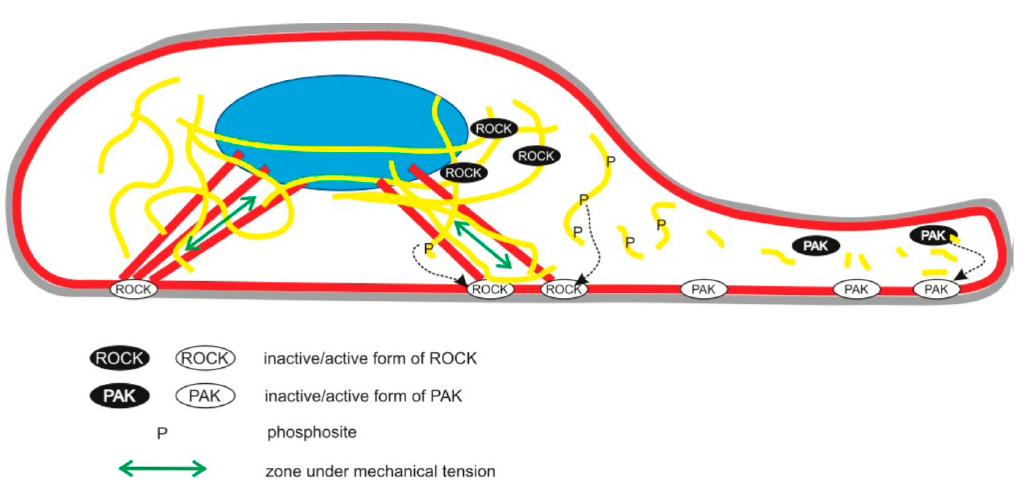
Figure 5. Working hypothesis. Image showing the plasma membrane (grey), nucleus (blue), actin cytoskeleton (red), and vimentin filaments (yellow). The localization of the active and inactive configurations of the ROCK and PAK kinases and S71-phosphorylated vimentin are shown, as indicated. We speculate that at cell regions where the F-actin stress fibers and vimentin filaments are subjected to mechanical load through their linkage to FAs (as indicated with green arrows), the S71 phosphorylation of vimentin filaments would result in lower affinity for ROCK, ROCK translocation to the plasma membrane, and its activation, and an increased mechanical load. We suggest that in cell areas where vimentin is not under mechanical load, S71 phosphorylation would result in severing of vimentin filaments into smaller units, which may stimulate Rac-PAK signaling, and promote vimentin severing and lamellipodium formation. Thereby, the level of the mechanical load would govern which of these two counteracting pathways is stimulated by S71 vimentin